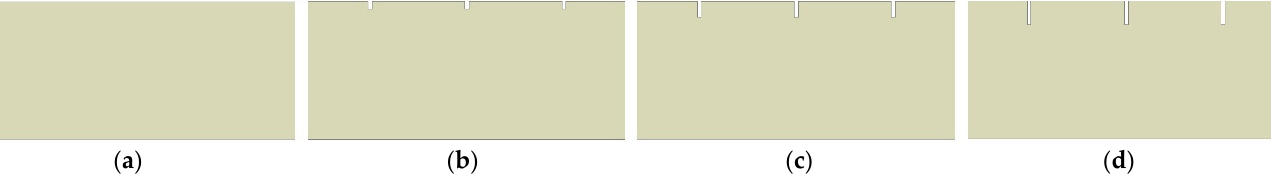
Figure 18. Stage 0: h = 0 mm ( a ); Stage 1: h = 10 mm ( b ); Stage 2: h = 20 mm ( c ); Stage 3: h = 30 mm ( d ).